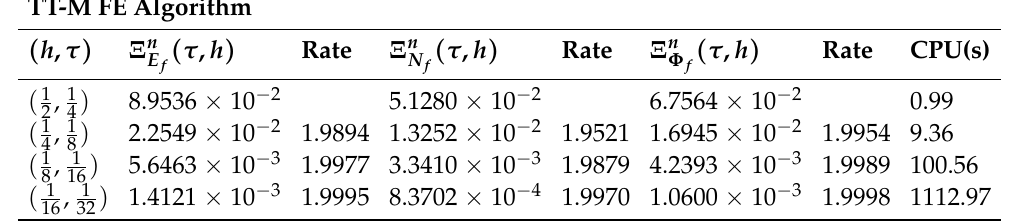
Table 6. Space-time convergence results for Example 2 in Case 2 with τ = 1